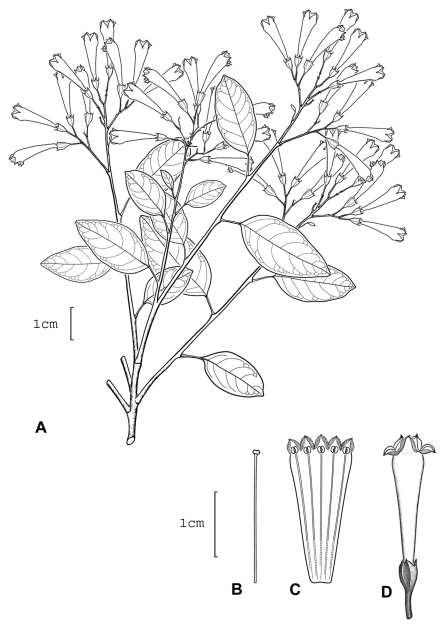
Cestrum talamancaenseA.K.Monro A Flowering stem B Stamen C Longitudinal section through the corolla showing stamen arrangement D Flower. Drawn from A.K. Monro, B.B. Klitgaard & J. DeGracia 4054 (BM)